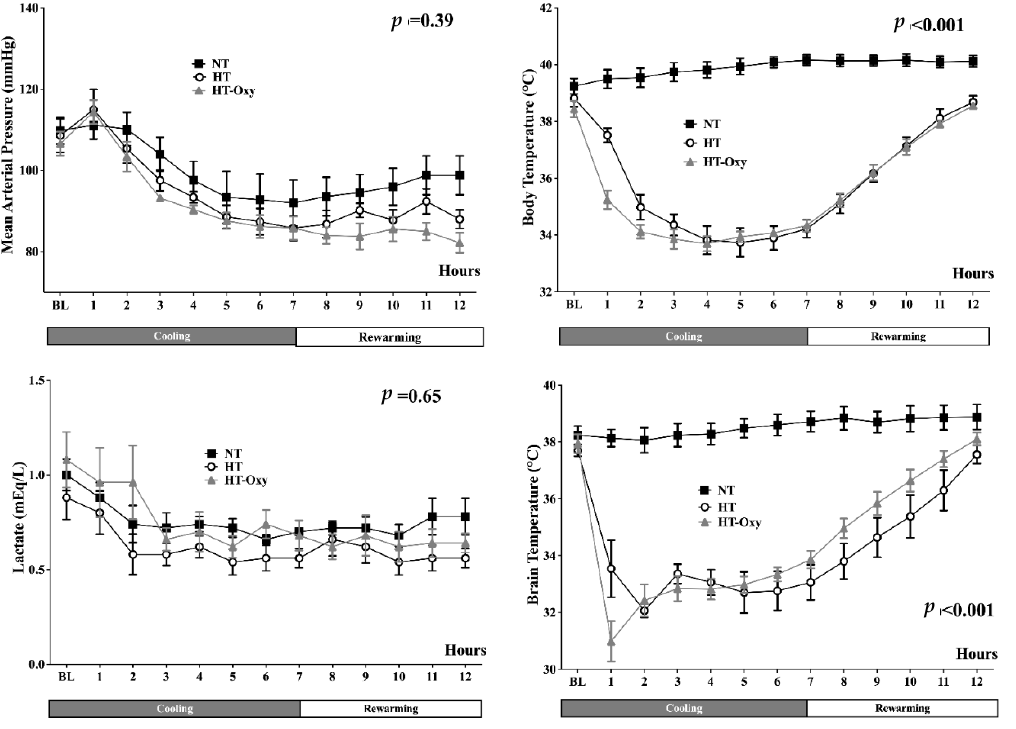
Figure 1. Time-course of mean arterial pressure, lactate concentrations, body and brain temperatures in the normothermia (NT), hypothermia (HT) and hypothermia with PaO 2 concentrations kept constant with baseline values (HT-Oxy). p -value indicated differences over time between groups.